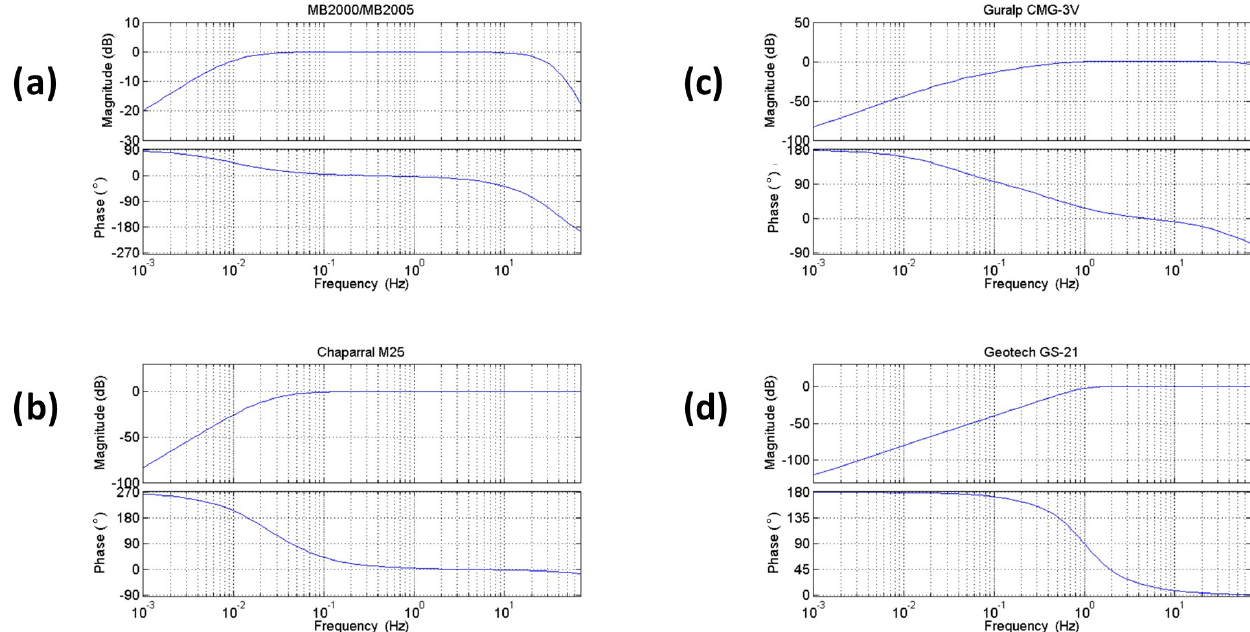
Figure A1. Normalized frequency response of the (a) MB2000 and MB2005, (b) Chaparral M25 microbarometers, (c) Guralp CMG-3V, and (d) Geotech GS-21 seismometers.